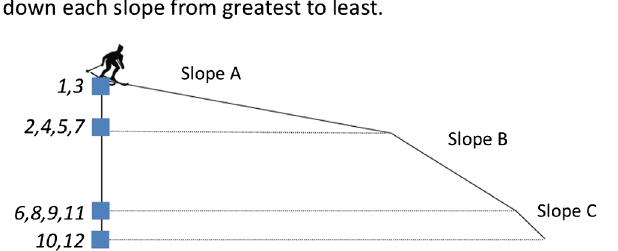
FIG. 11 (color online). Skier problem overlaid with visual cues.